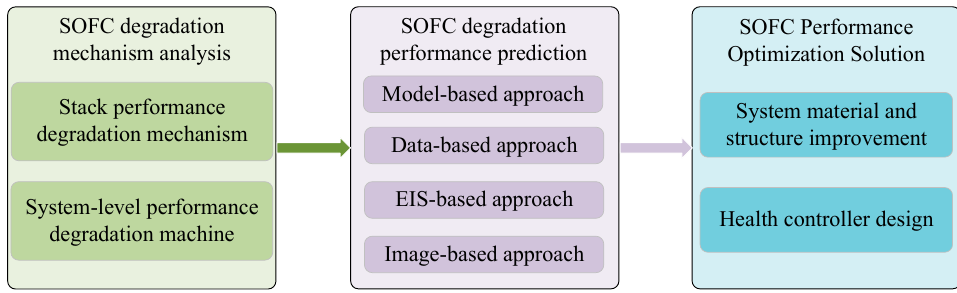
Figure 1. Solid oxide fuel cell (SOFC) performance degradation study process.